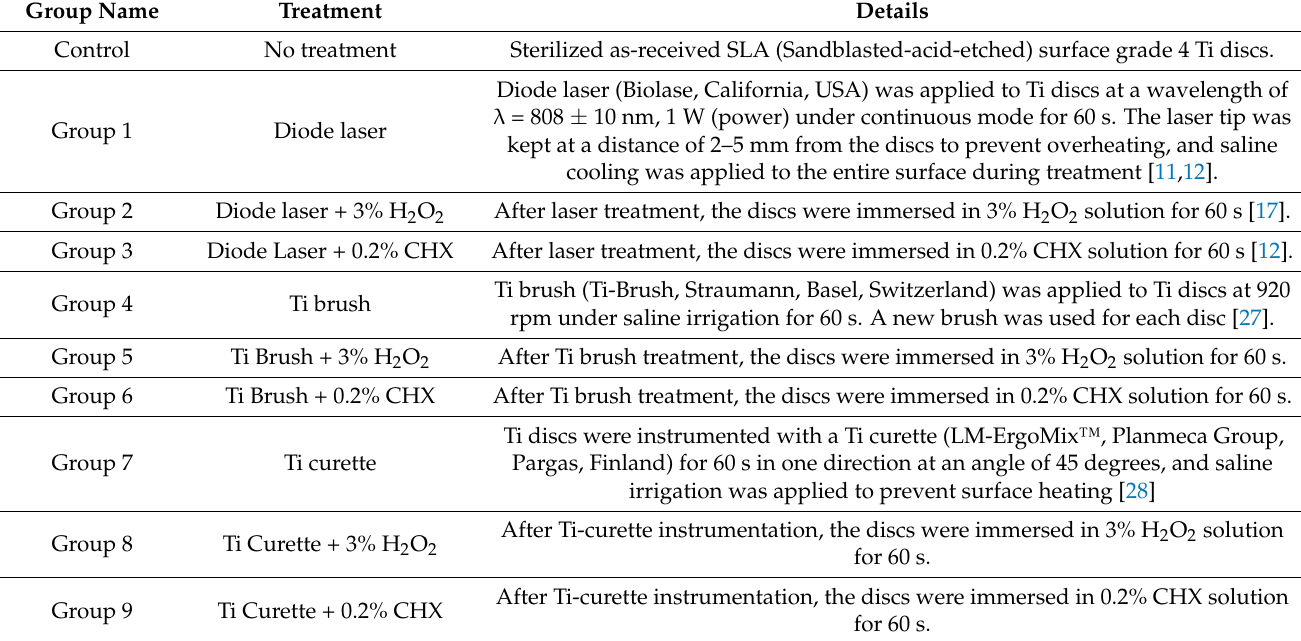
Table 1. Summary of various decontamination treatments investigated on SLA Ti